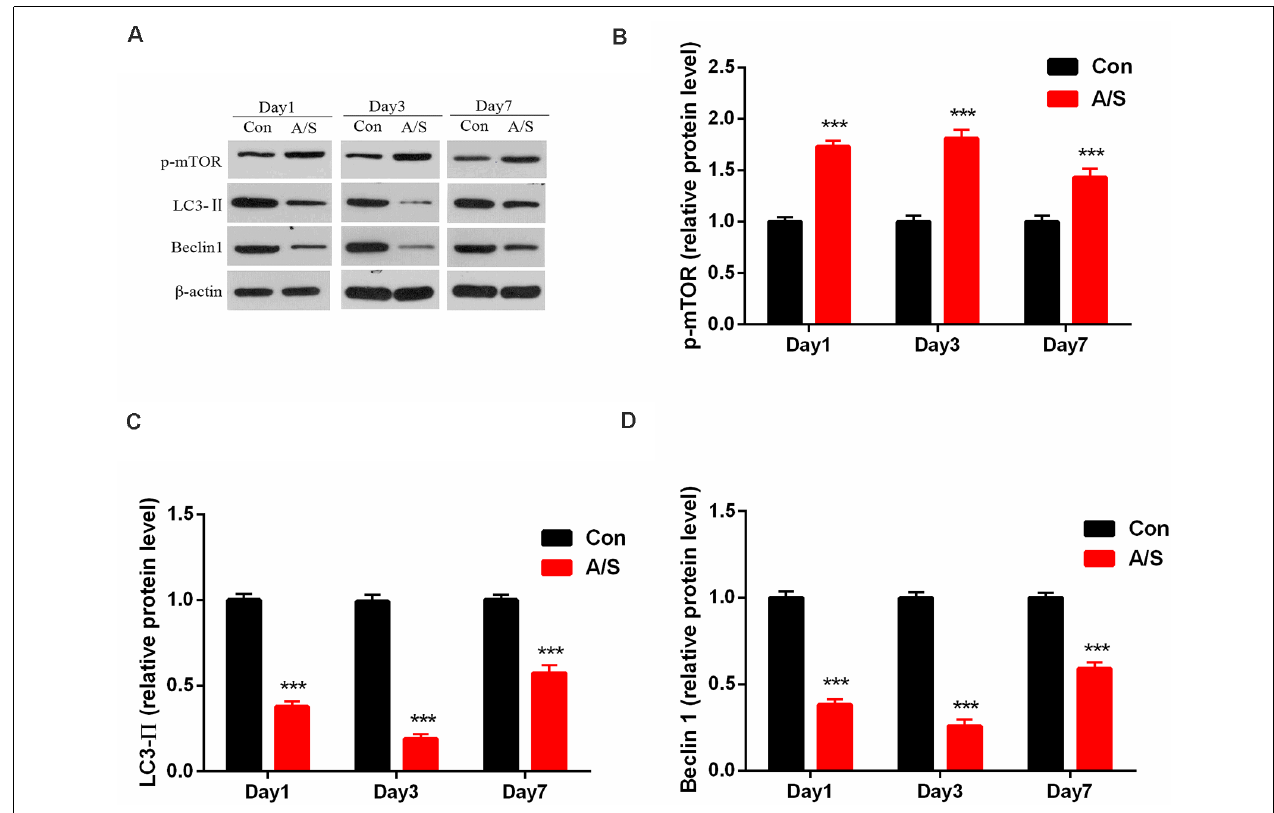
FIGURE 2 | Anesthesia and surgery increased the activation of mammalian target of rapamycin (mTOR) and decreased LC3-II and Beclin-1 levels in the hippocampus. (A) Representative western blot illustrating p-mTOR, LC3-II and Beclin-1 levels in the hippocampus on days 1, 3 and 7 after surgery. (B) Anesthesia/surgery increased p-mTOR expression in the hippocampus on days 1, 3 and 7 after anesthesia/surgery. (C,D) Anesthesia/surgery reduced LC3-II and Beclin-1 levels in the hippocampus on days 1, 3 and 7 after anesthesia/surgery. Data are mean ± SEM ( n = 6 per group). *** p < 0.001 vs. Con. Con, control group; A/S, anesthesia/surgery